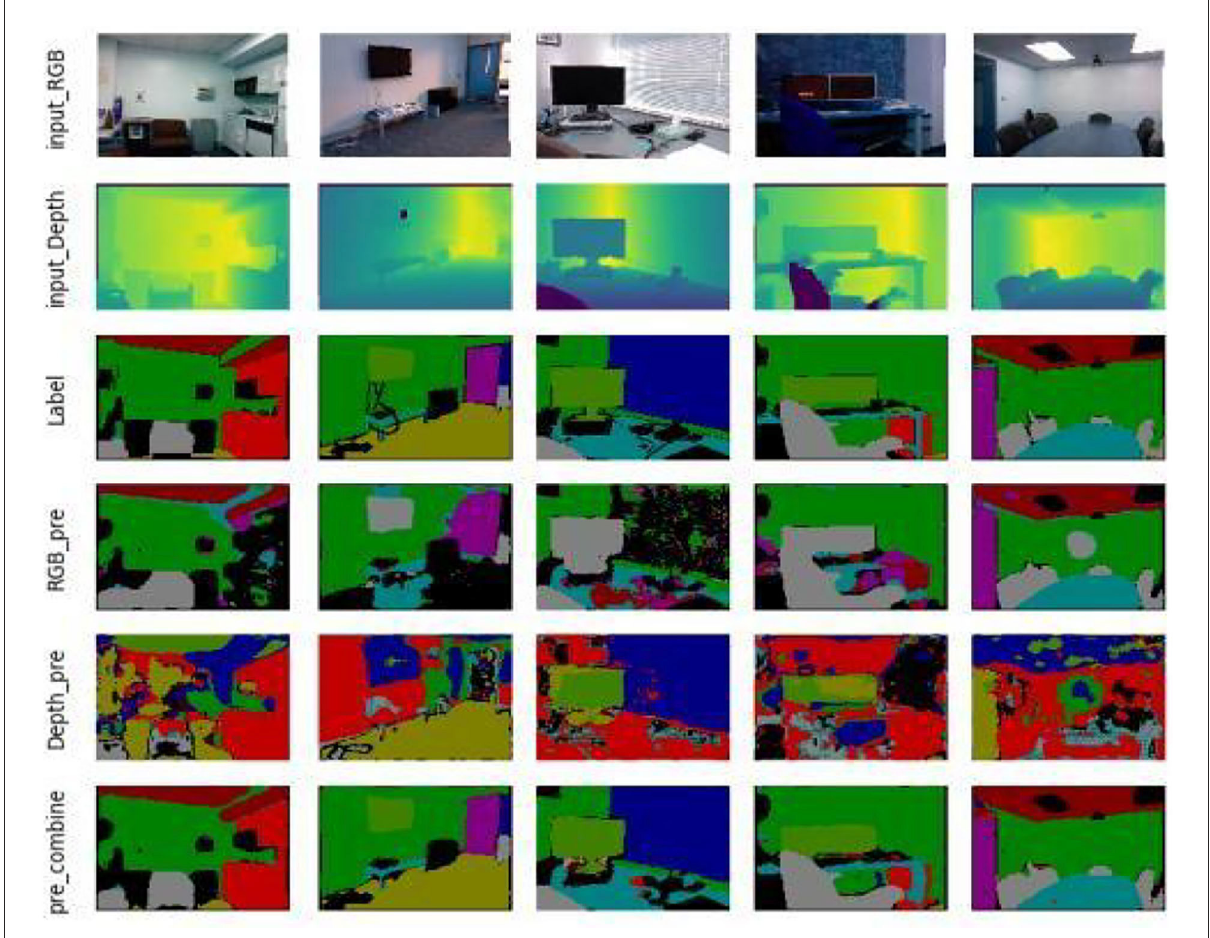
FIGURE10 Semantic segmentation results for test